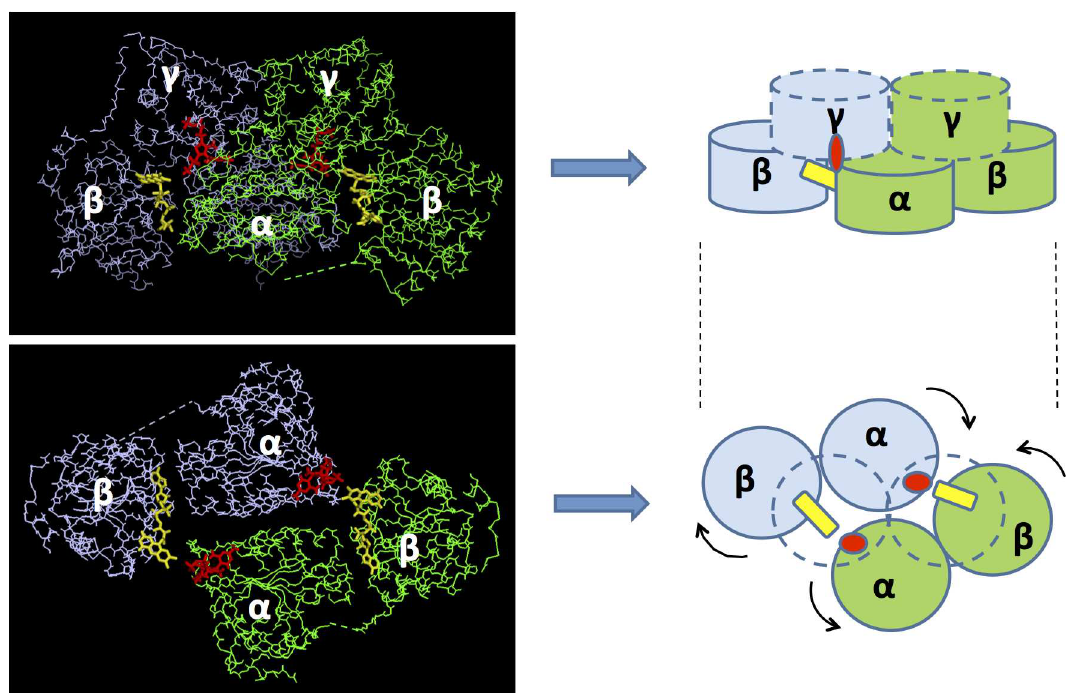
Fig 3. The structure of the Sc AHAShomodimer is asymmetric. Left images represent the polypeptideof Sc AHAS showingthe configuration of the α , β , and γ -domains of the two subunits(green and blue). In the lower panel, the γ -domains have been removedfrom the image in order to allow visualizationof the asymmetry of α and β -domains in the two subunits. Cartoonson the right schematize the configuration of the domains.Yellowrectanglesrepresent FAD, and red ellipses represent